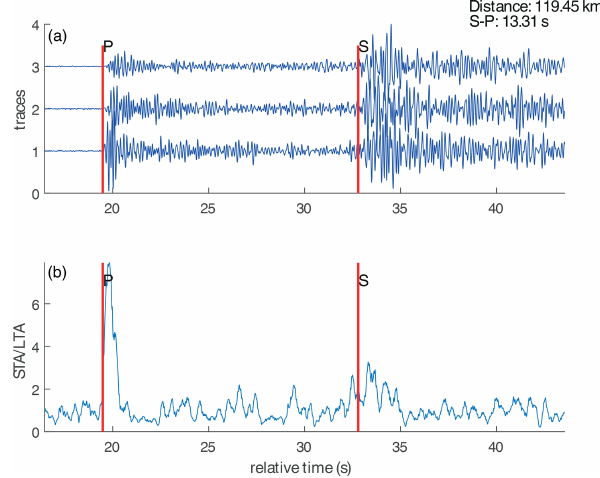
Figure 5. Estimating the epicentral distance from the arrival-time difference between S and P waves at the reference station 1. The vertical, north, and east components are shown by traces 1, 2, and 3, respectively (a) . The vertical red lines show manually picked P and S phases. The picking is aided by calculating the STA / LTA of the Z component (b)